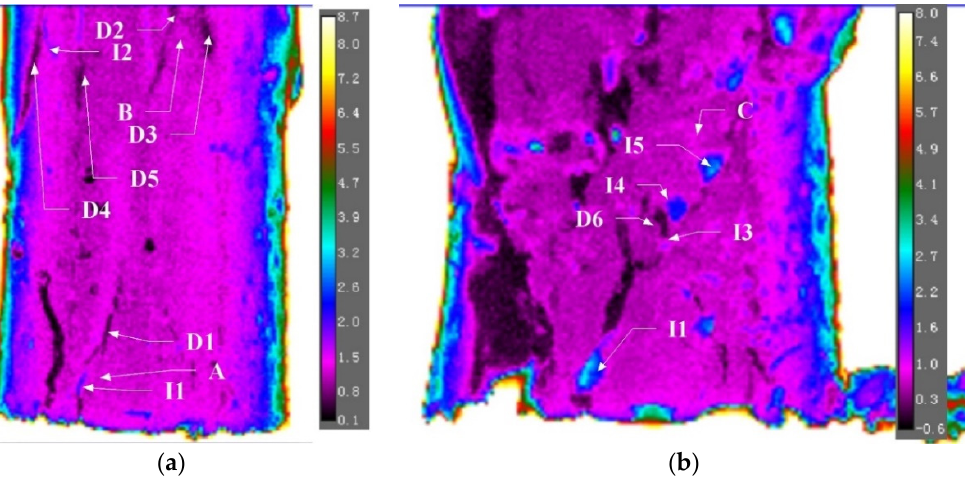
Figure 12. Locations of cracks before plastic deformation ( a ) and after plastic deformation ( b ).